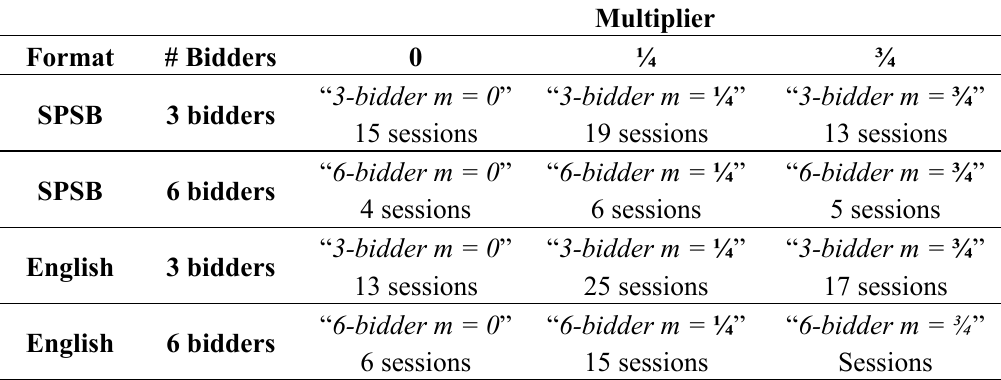
Table 1. Different experimental conditions and number of sessions in each